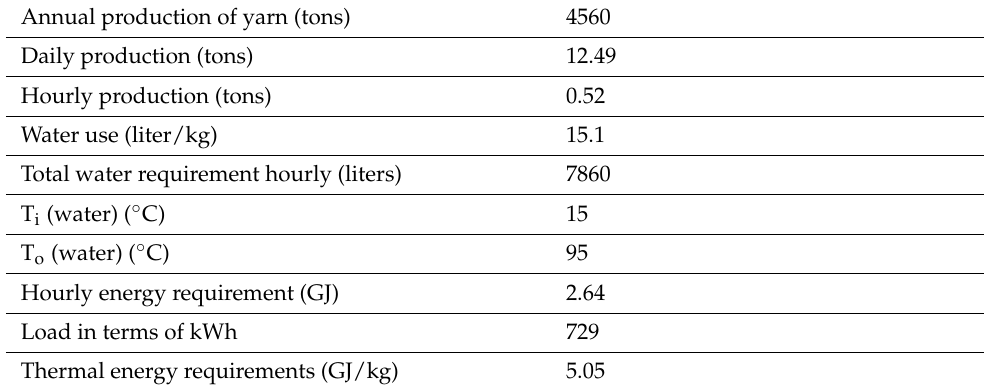
Table 2. Thermal energy requirement for 4560 tons yarn in one year.